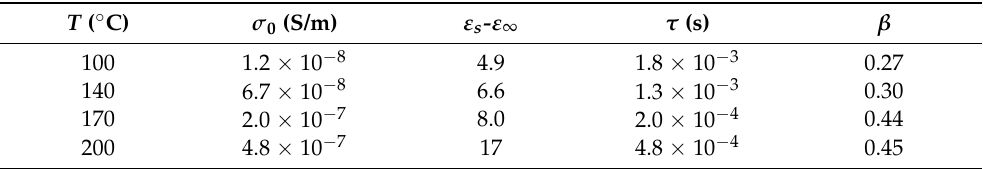
Table 1. Values of σ 0 , ε s - ε ∞ , τ , and β used in the fitting of the observed frequency dependence of σ AC in the HAp-collagen composite